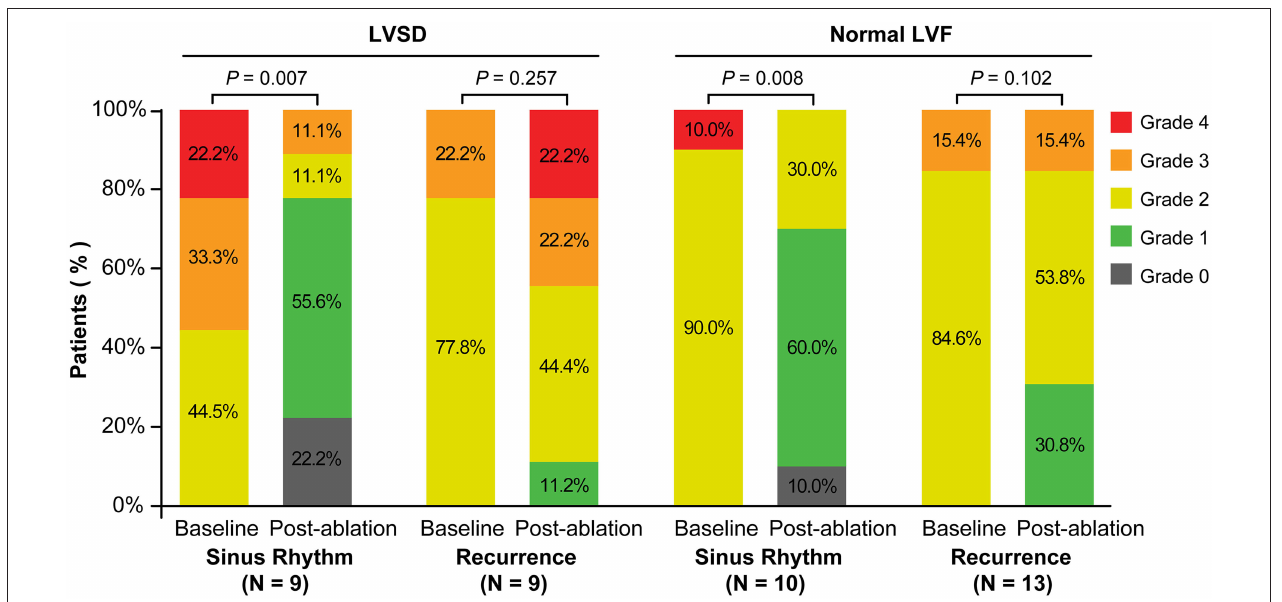
FIGURE 2 | Severity of MR at baseline and post-ablation according to recurrence of atrial fibrillation or sinus rhythm categorized by the rhythm at the time of follow-up in patents with LVSD and normal LVF. LVSD, left ventricular systolic dysfunction; LVF, left ventricular function.